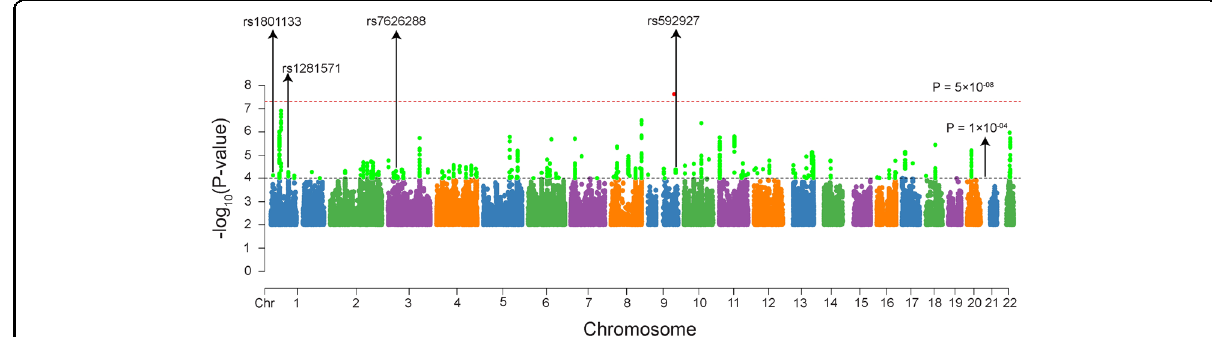
Fig. 1 Manhattan plot of EOS GWAS associations. Associations were from the GWAS meta-analysis of the discovery stage ( N = 1,256 EOS cases and 2,661 controls). The dashed black horizontal line indicates the suggestive P threshold ( P < 1.0 × 10 − 04 ). The genome-wide signi fi cant P threshold ( P < 5.0 × 10 − 08 ) is represented as the dashed red horizontal line. The arrows indicate the four genome-wide signi fi cant SNPs in our combined discovery and replication samples.